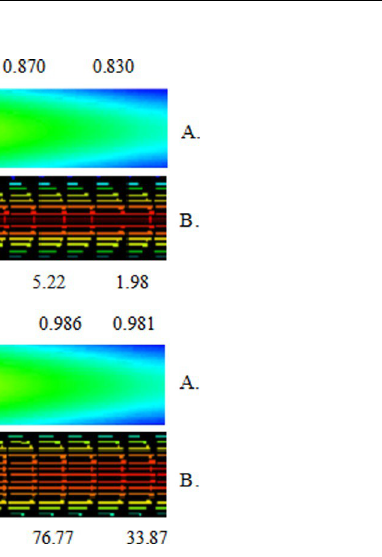
Fig 5. Air temperature (dimensionless) (A), air speed distribution (m s -1 ) (B), in the gas heat generator as a function of Reynolds number (speed), convective heat transfer coefficient, and drying air temperature ( u = 1500 / h = 0.1 / 60˚C and u = 100 / h = 0.01 /